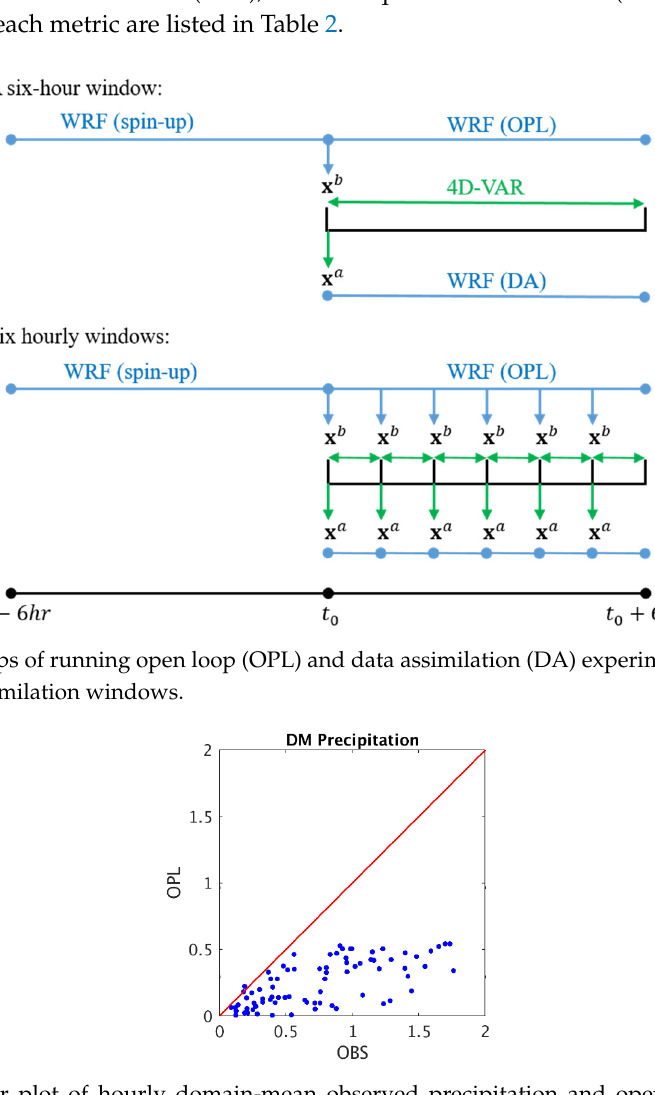
Figure 3. Scatter plot of hourly domain-mean observed precipitation and open-loop estimated precipitation (mm/h). Table 1. Experimental setup used in this